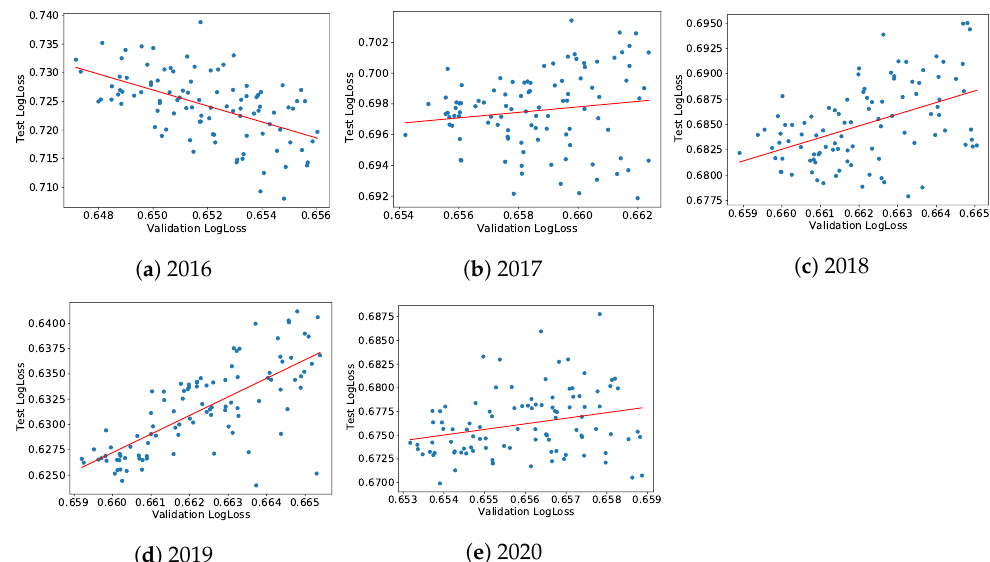
Figure 6. Company-wise cross-validation: test set cross-entropy versus validation cross-entropy of the 100 best models of the random hyperparameters search. Table 1. Dependence measures between the cross-entropies (prediction error) in the validation and test sets for the 100 best models of the random hyperparameters